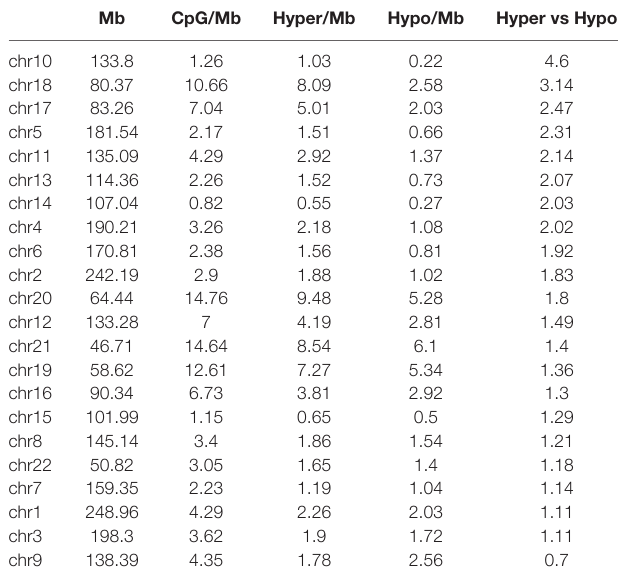
TABLE 1 | Distribution of differentially methylated CpG sites in different genomic and gene regions in pancreatic ductal adenocarcinoma (∆ β ≥ 0.2). Genomic region dm-CpG Hypermethylated